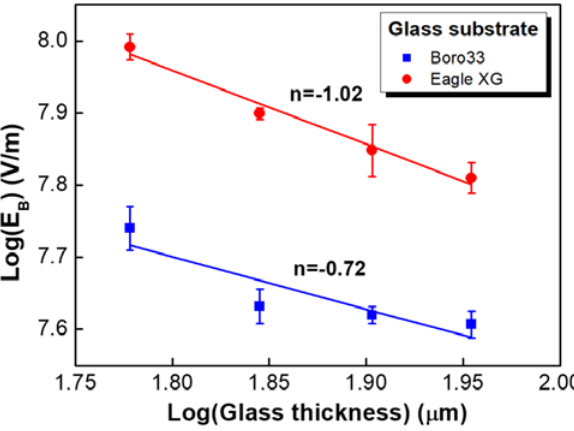
Figure 7. Breakdown strength of glass frit-bonded strain gauges as a function of glass thickness.